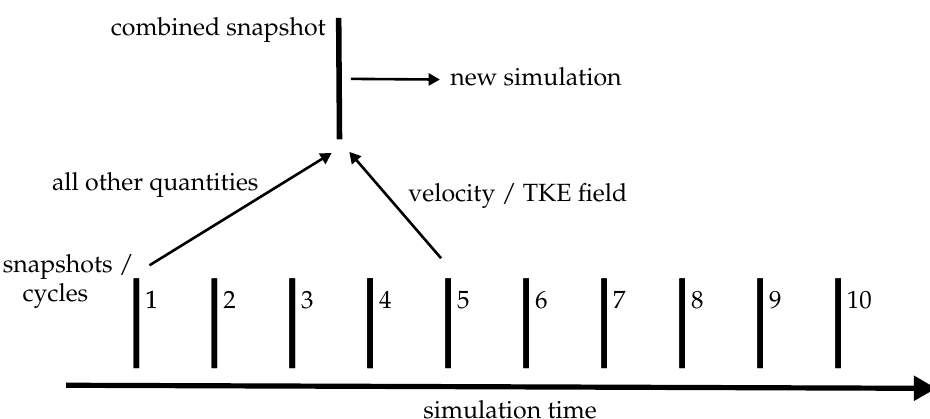
Figure 1. Generation of the evaluation data. Here, the velocity and TKE field is extracted from the fifth cycle and combined with all other quantities of the first cycle. Then, the simulation starts at the time that the fifth snapshot was